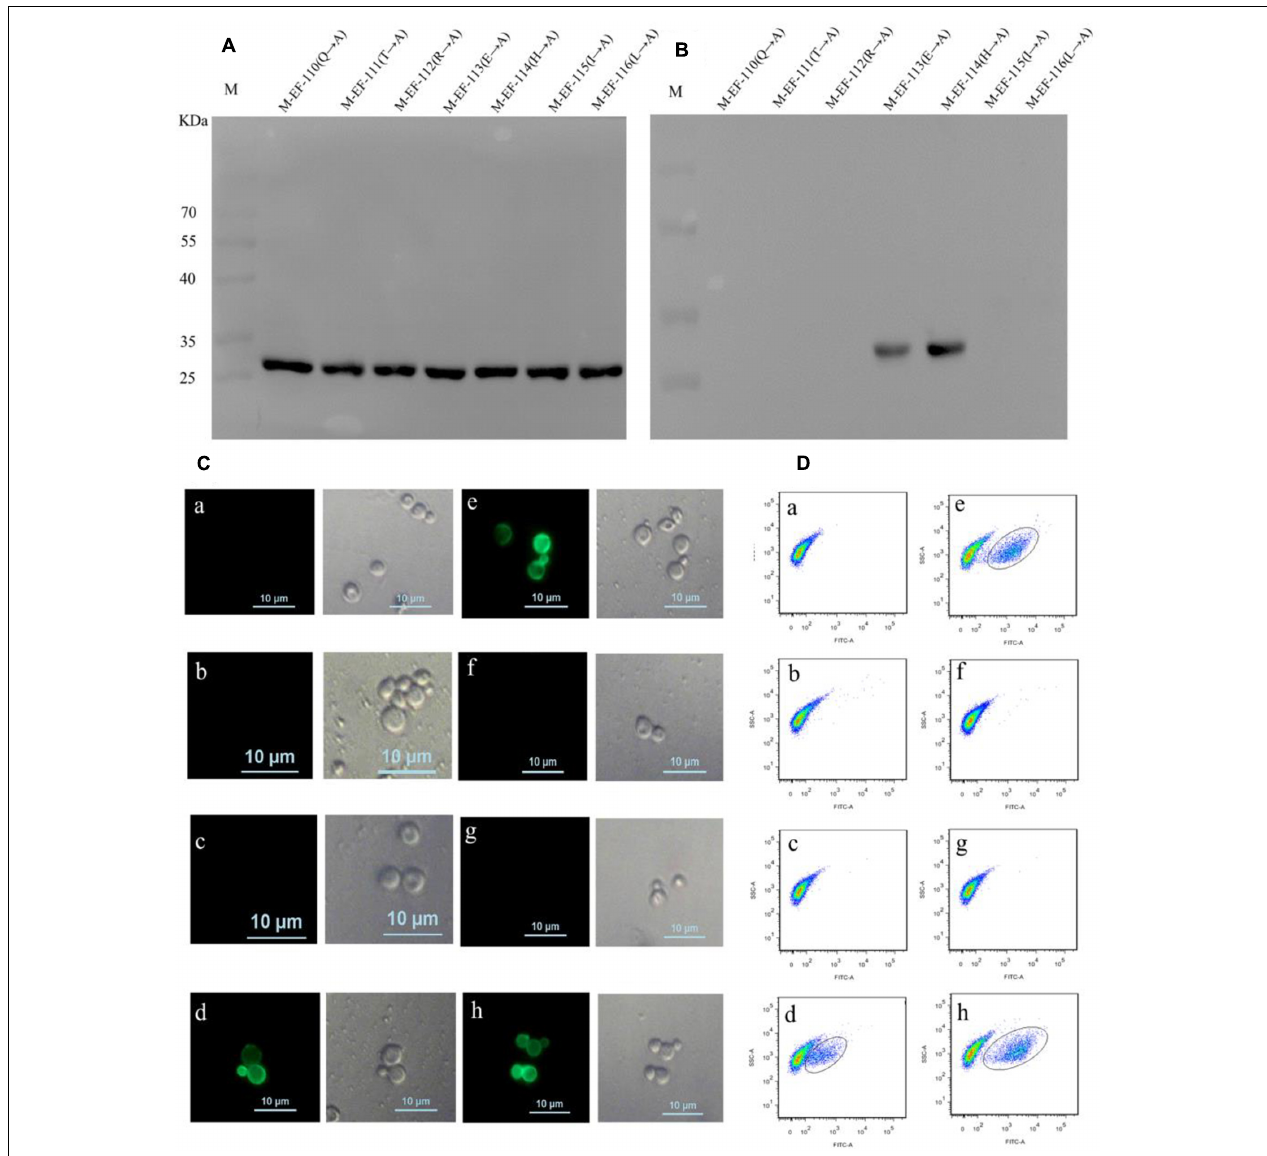
FIGURE 3 | Identification of the crucial residue of the epitope to McAb BD 6 . (A) Western blotting analysis of seven mutagenesis epitope peptides expressed in E. coli BL21 (DE3) using anti-GST McAb as primary antibody. (B) Western blotting analysis of seven mutagenesis epitope peptides by western blotting to confirmed central sequence of epitope, using McAb BD 6 as primary antibody. (C,D) Indirect immunofluorescence assay (C) and flow cytometry (D) analysis yeast cells displayed seven mutagenesis EF-Tu proteins. (a) Yeast cell displaying P-EF-Tu-(Q 110 -A) protein; (b) yeast cell displaying P-EF-Tu-(T 111 -A) protein; (c) yeast cell displaying P-EF-Tu-(R 112 -A) protein; (d) yeast cell displaying P-EF-Tu-(E 113 -A) protein; (e) yeast cell displaying P-EF-Tu-(H 114 -A) protein; (f) yeast cell displaying P-EF-Tu-(I 115 -A) protein; (g) yeast cell displaying P-EF-Tu-(L 116 -A) protein; and (h) yeast cell displaying B. melitensis EF-Tu protein as positive control. BD 6